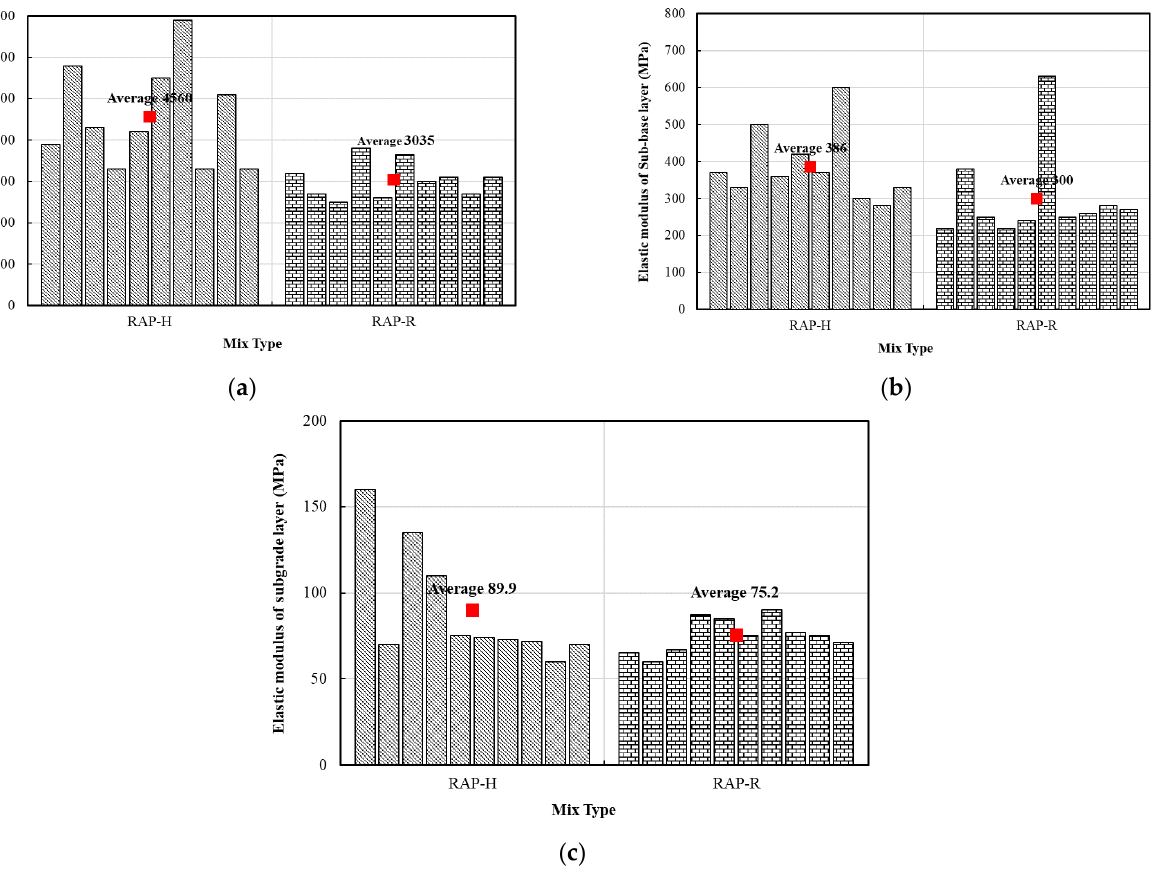
Figure 17. Back calculation analysis: ( a ) surface layer, ( b ) sub-base layer, ( c ) sub-grade layer.